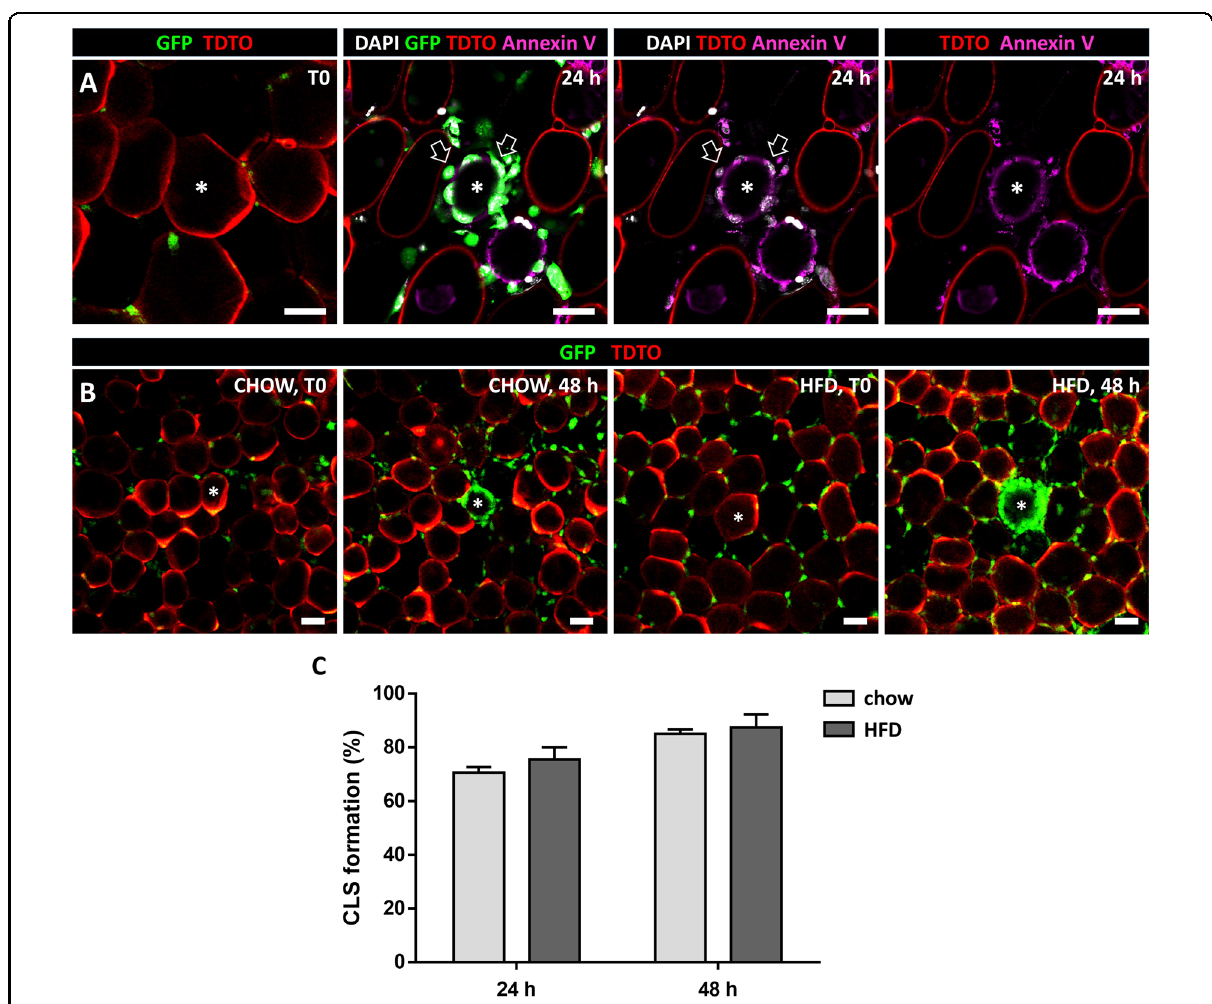
Fig. 3 Characterization of adipocyte death and CLS formation post laser injury. A Phosphatidylserine externalization detected via Annexin V staining (magenta) 24 h post laser injury. Nucleus of depleted adipocyte shows no DAPI staining, while some surrounding ATMs are DAPI positive (white; highlighted by arrows), validating DAPI staining ( N = 3). B Induced CLS formed 48 h post laser injury in AT explants of chow-fed (chow) and HFD-fed (HFD) mice. C Frequency of CLS formation after laser injury ( N = 3). Asterisks mark depleted adipocytes, scale bars = 50